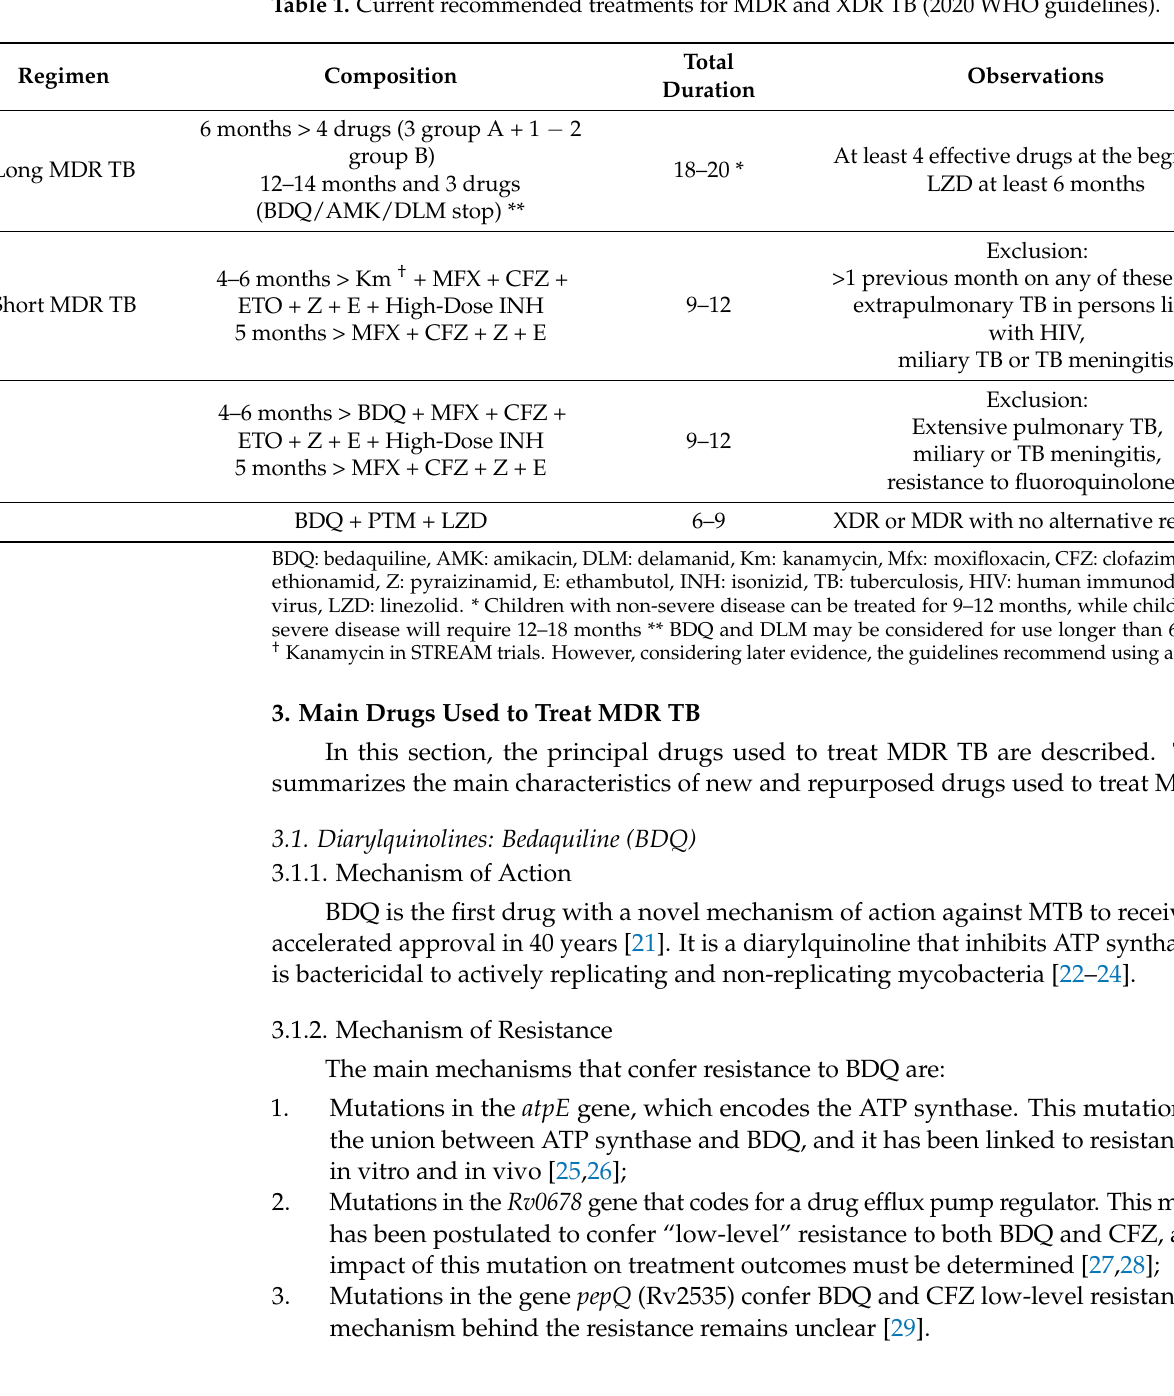
Table 1. Current recommended treatments for MDR and XDR TB (2020 WHO